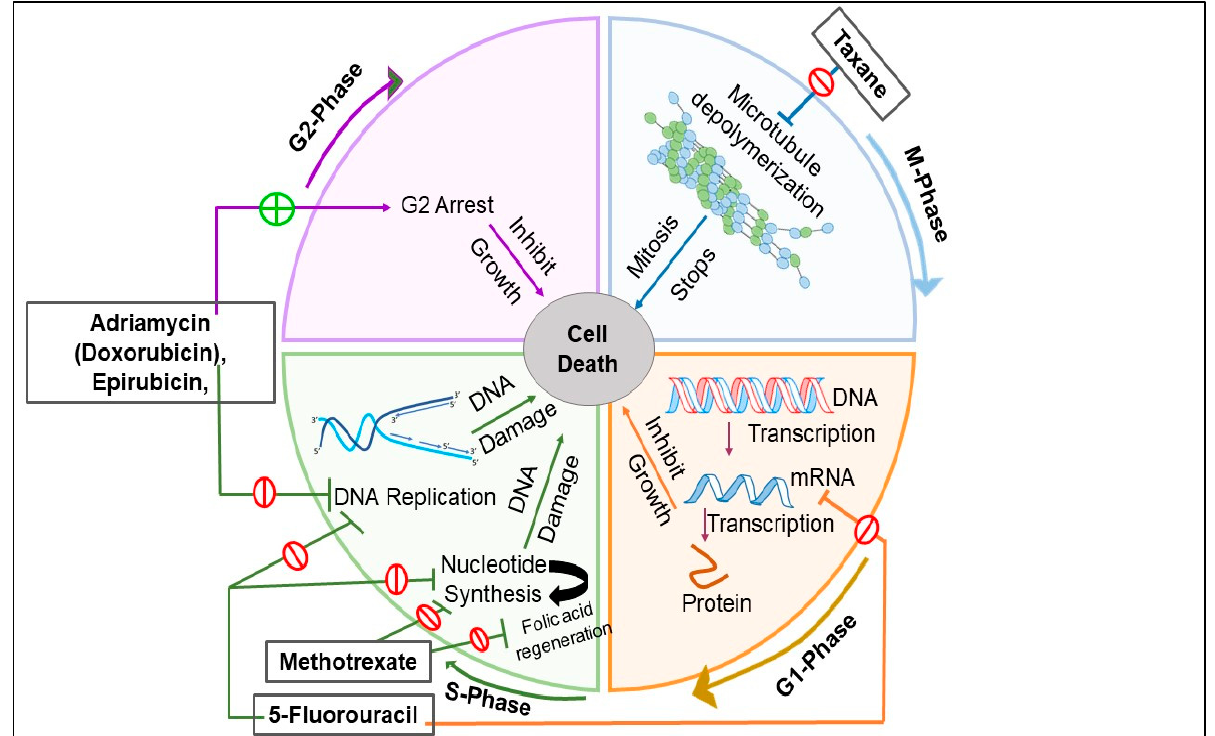
Figure 4. Mechanism of action of the combined drug regimen.